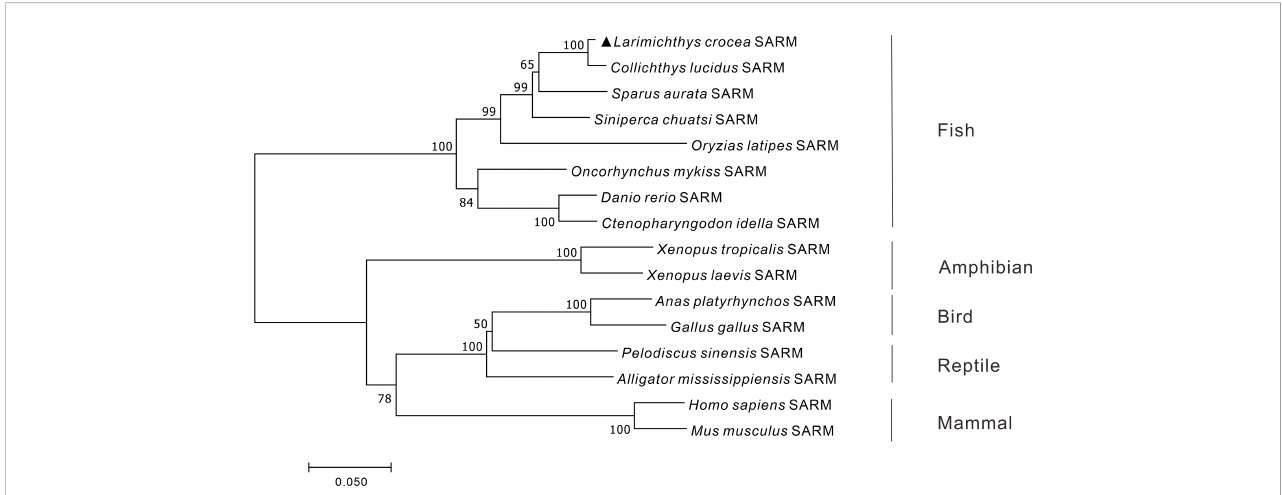
FIGURE 1 Phylogenetic analysis of vertebrate SARM. The phylogenetic tree was constructed base on the protein sequences of vertebrate SARM by using the neighbor-joining method within the MEGA version 7.0 software, with 10,000 replications of the bootstrap test. The GenBank association numbers of the SARM orthologues are shown as follows: L. crocea , OP225399; C. lucidus , TKS81088.1; Sparus aurata , XP_030249993.1; S. chuatsi , QWW30847.1; O. latipes , XP_004075485.1; O. mykiss , XP_036821319.1; D. rerio , NP_001124068.1; C. idella , AGM20429.2; X. tropicalis , XP_002937189.2; X. laevis